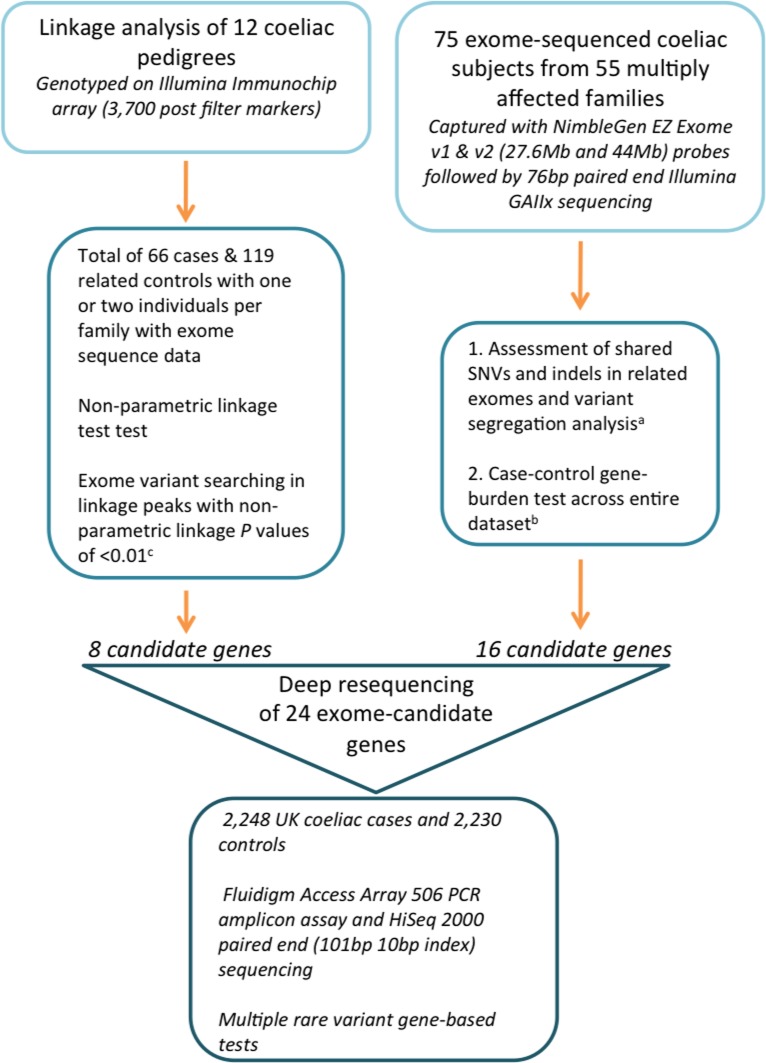
Analytical design of our study of rare variation in CeD.Only post quality filtered SNVs and indels were included in each analytical test. A, Not in dbSNP132, <5% MAF in 1000G, <10% MAF in coeliac exomes, not in 101 control exomes (54 ultra rare diseases from Kings College London and 47 Environmental Genome Project samples from University of Washington). B, Rare allele defined as MAF <0.5% in 1000G (n = 1092) for 220 controls and 41 unrelated coeliac exomes. C, MAF <0.5%, only variants predicted to be damaging and regions without duplications.